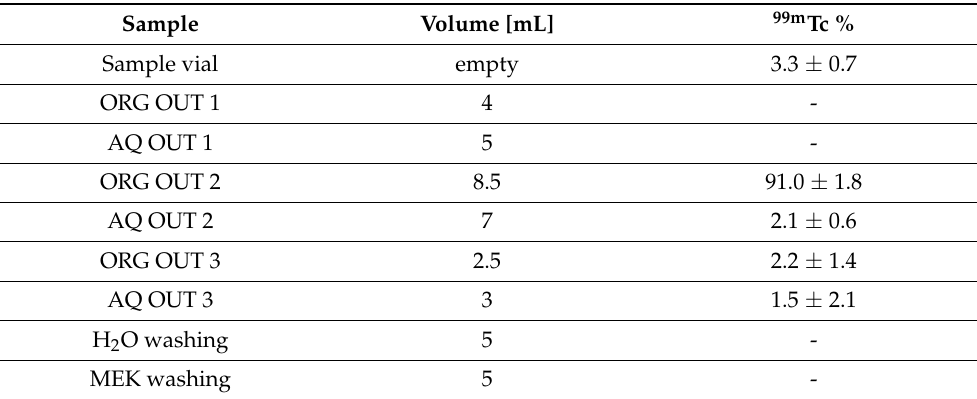
Table 1. Average percentage of extraction 99m Tc ( n = 3). (ORG/AQ OUT 1: preconditioning, ORG/AQ OUT 2: sample collection, ORG/AQ OUT 3: residual